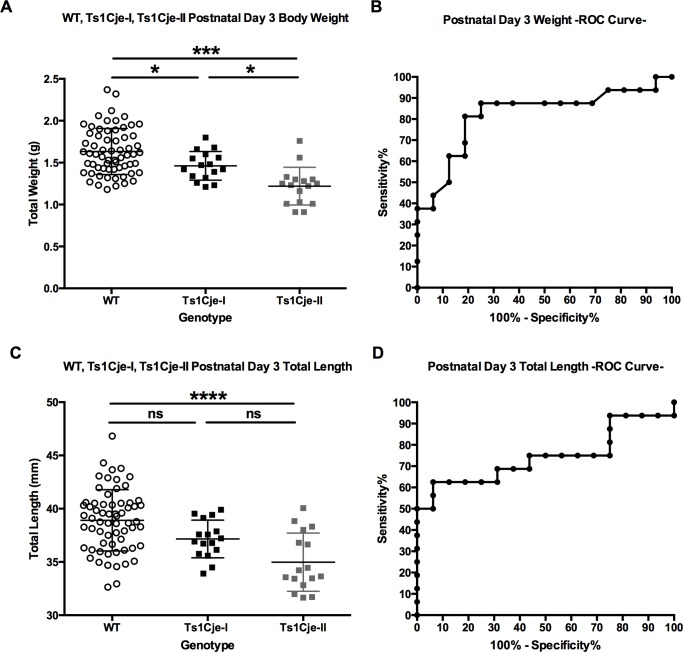
Growth Restriction Predicts Poor Postnatal Survival in the Ts1Cje Mouse Model.A,C) Body weight and length at postnatal day 3 of WT (n = 64), Ts1Cje-I (post-weaning survivors, n = 16) and Ts1Cje-II (pre-weaning deceased, n = 16). B,D): Receiver Operating Characteristic (ROC) curve representing the % sensitivity (the fraction of Ts1Cje pups that the test identifies as growth restricted) and % specificity (the fraction of Ts1Cje pups that the test identifies as non-growth restricted) at postnatal day 3 in the Ts1Cje mouse model. The ROC analysis showed that early postnatal body weight was a better predictor of postnatal survival in the Ts1Cje mouse model compared to body length (area under the curve = 0.82 for weight and 0.74 for length, p = 0.002 and 0.019, respectively). Data are represented as mean ± SEM.